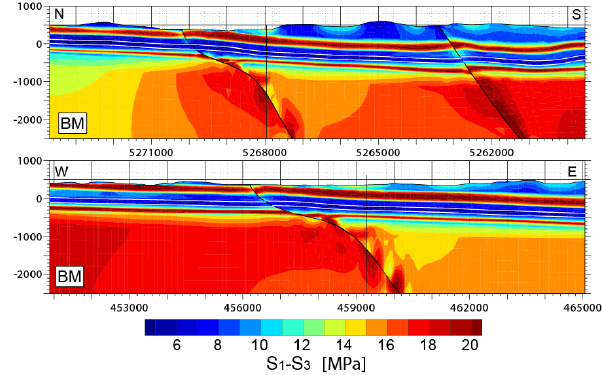
Figure 11. Differential stress S 1 − S 3 in the base model BM along north–south and west–east cross sections through the Weiach well. Thin white lines indicate top and bottom of the Opalinus